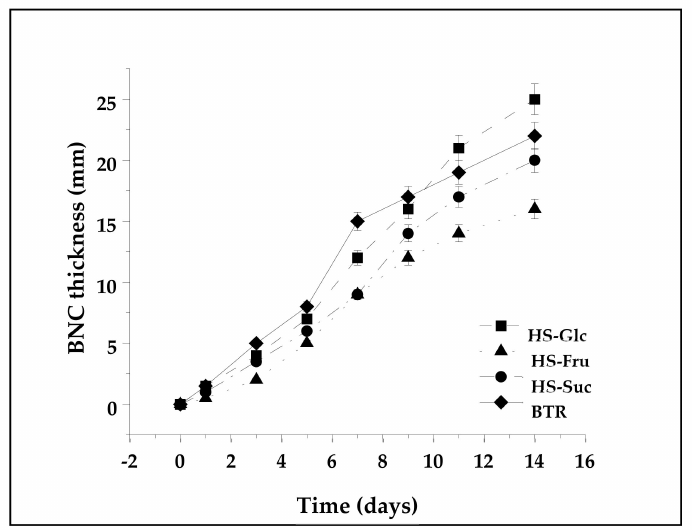
Figure 3. The kinetic pattern of BNC pellicle synthesis in media with different